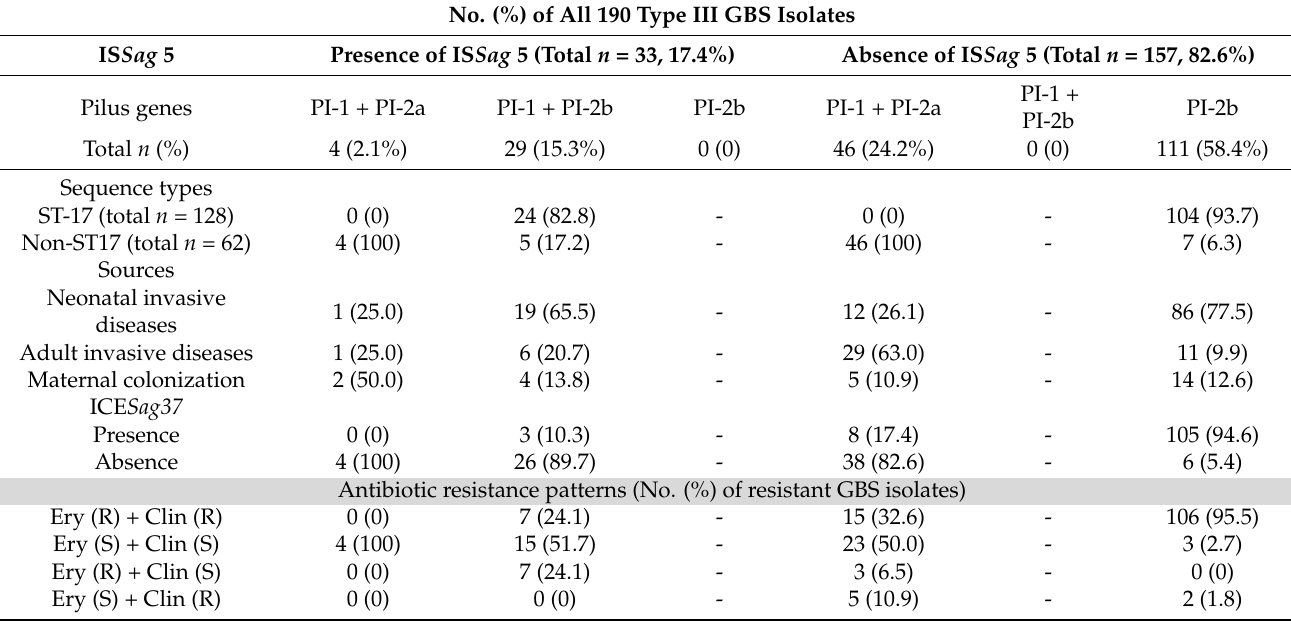
Table 4. The antibiotic susceptibility patterns, pilus distribution and presence of IS Sag 5 in all serotype III GBS isolates.